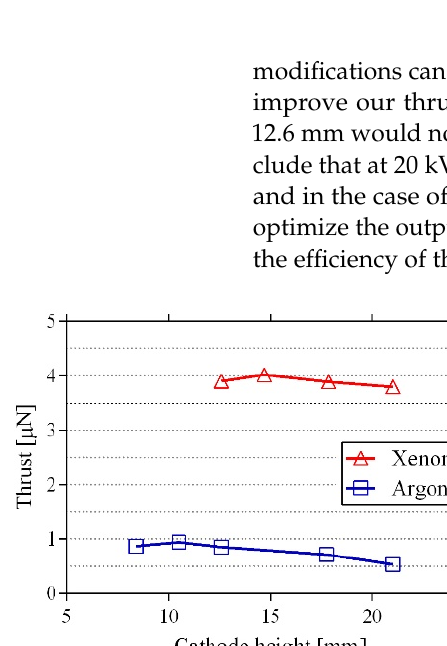
( b ) Figure 3. Influence of the cylindrical inner radius in the thruster’s performance at 20 kV: ( a ) variation